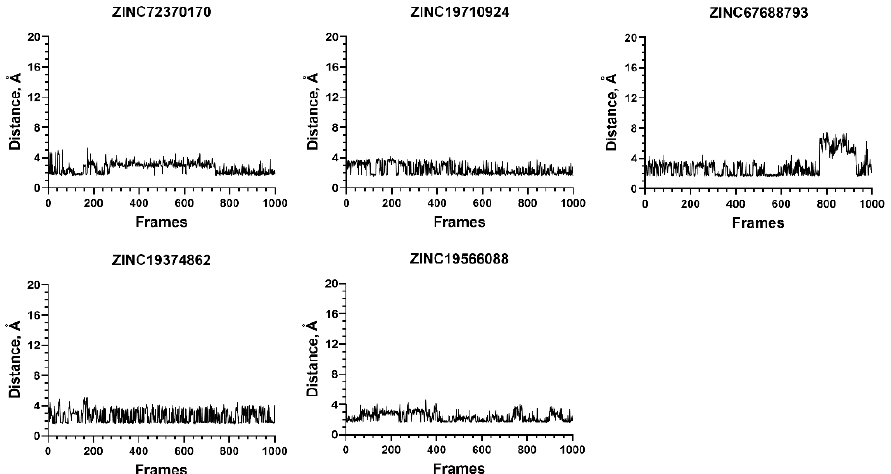
Figure 10. Stability of the ligand – protein complexes for compounds that form a salt bridge with C- terminus of NMT1. The graphs depict the length of the salt bridge at the different frames of MD simulations. The salt bridge is considered stable if its distance does not exceed 4 Å . The complex of ZINC353458799 (second row, right) displays partial stability; initially, the salt bridge is disrupted, but later, it is re-formed (after frame 650). The complex of ZINC67688793 (fifth row, right) is at least partly unstable, because the salt bridge becomes disrupted in frames 780 – 960. Altogether, the results emphasize the role of the salt bridge in formation of stable ligand – protein complexes.